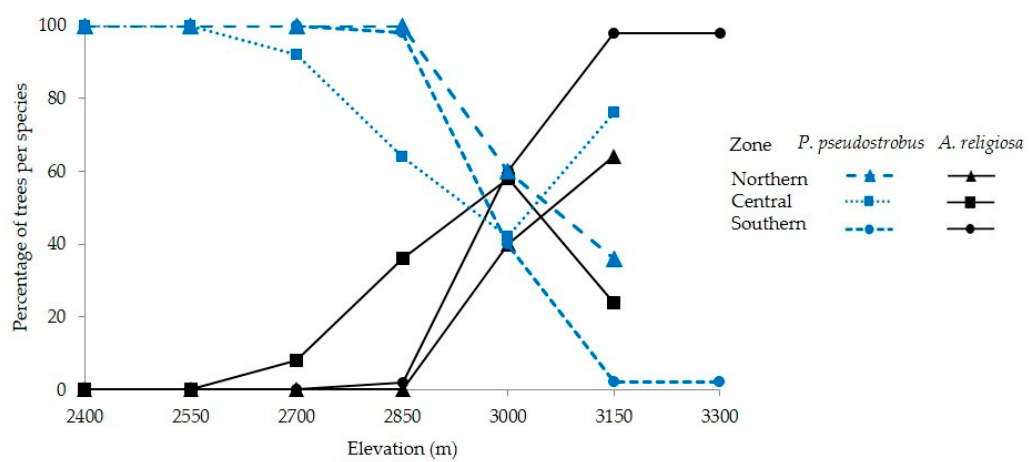
Figure 3. Proportion of P. pseudostrobus (broken lines) and A. religiosa (continuous lines) trees along an altitudinal gradient in the MBBR, in the northern (triangles), central (squares), and southern (circles) zones.